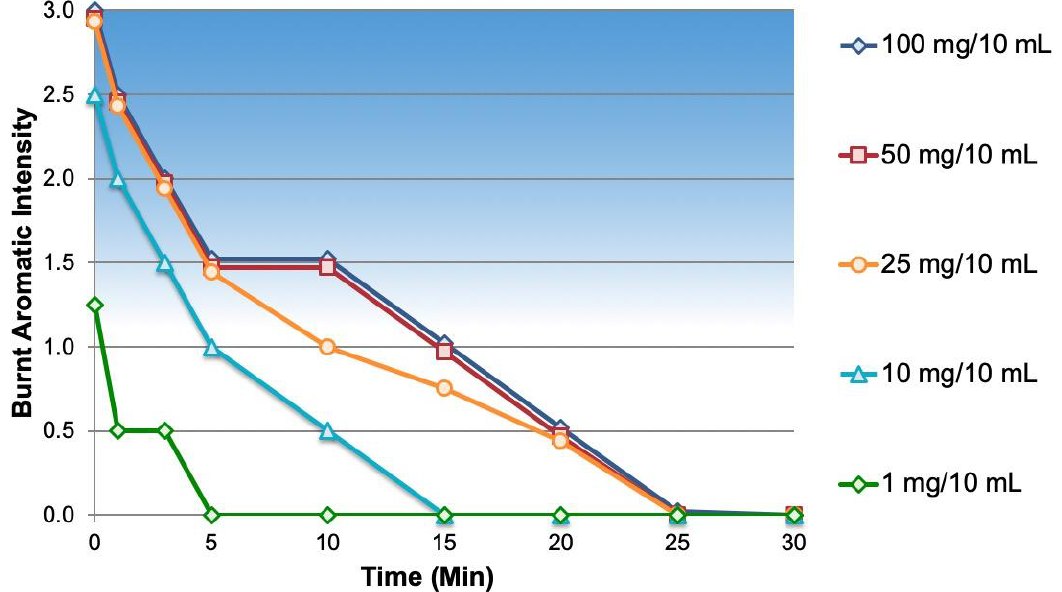
Figure 4. Burnt aromatics dose/response of NOP.